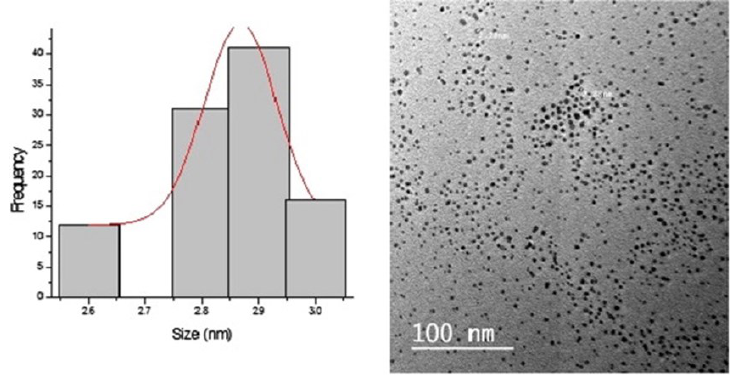
Figure 4. Size distribution histogram and HR-TEM micrograph of Ag NPs using the extract of the fungus Rhizopus stolonifer starting from an aqueous solution of AgNO 3 at 10 −2 M and at 40 °C.